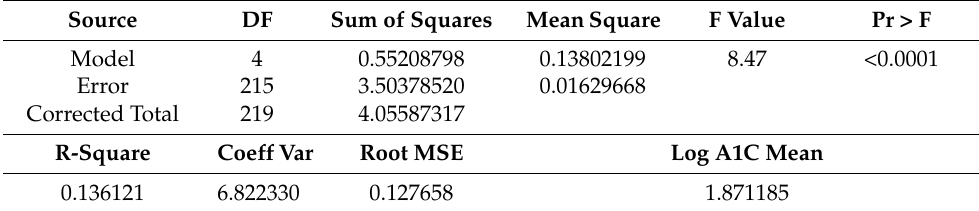
Table A4. GLM with log A1C as dependent variable.